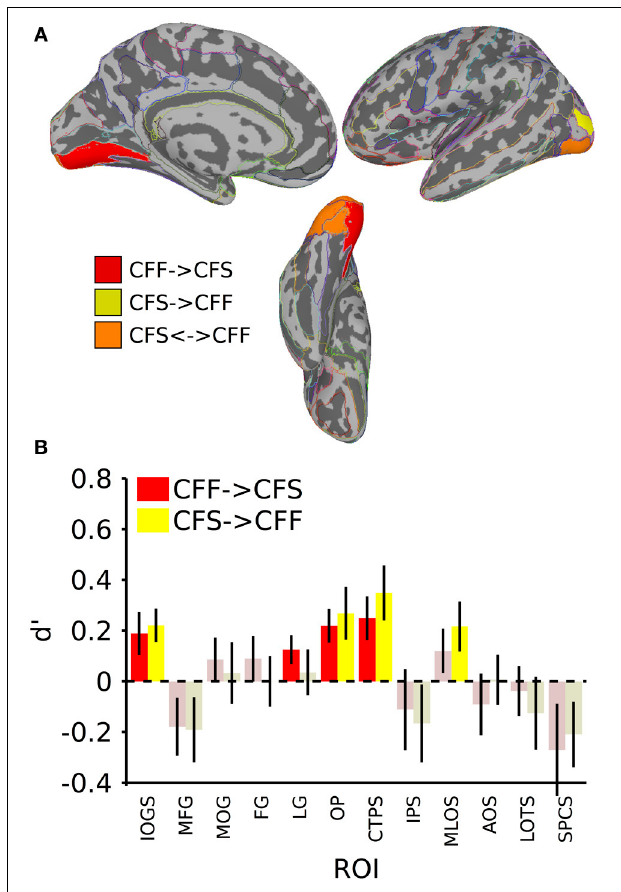
FIGURE 3 | Results for classification across invisible presentation methods. (A) Colored anatomical ROIs indicate regions where category classification was significantly above-chance ( p < 0 . 05 FDR-corrected) when performing cross-method category classification between the invisible methods (CFF and CFS). (B) Bar graphs of all regions where significant cross-method category classification was possible. Full region names for the ROI abbreviations can be found in Table 2 . Saturated (yellow and red) colors indicate significant classification, whereas desaturated (light red, light green) colors indicate non-significant